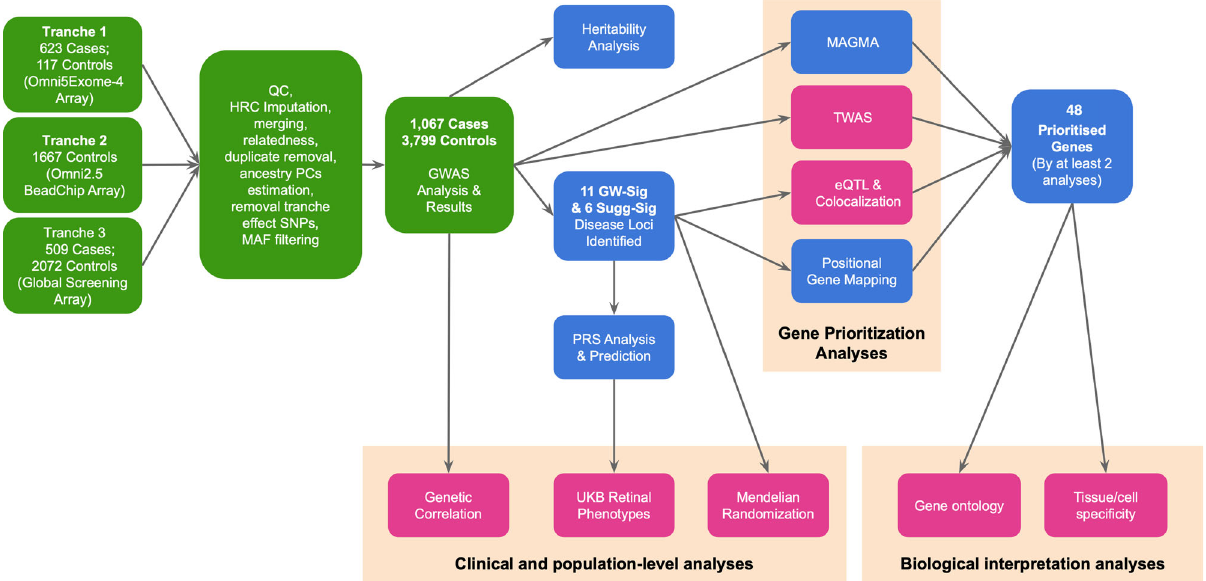
Fig. 1 Flowchart of the analyses performed in this study. Each box represents either a set of data or an analysis performed in this study. Green boxes highlight GWAS analyses, while the rest are post-GWAS investigations. The analyses presented in pink boxes employ both data from the current GWAS as well as publicly available data. Orange clusters represent analyses performed to achieve an overall task. GW-Sig genome-wide signi fi cant, Sugg-Sig suggestive signi fi cant, TWAS transcriptome-wide association analysis, eQTL expression quantitative trait loci, PRS Polygenic Risk Score, UKB UK Biobank. Details for the 11 GW signi fi cant and 6 suggestive-signi fi cant loci are provided in Tables 1 and 2.